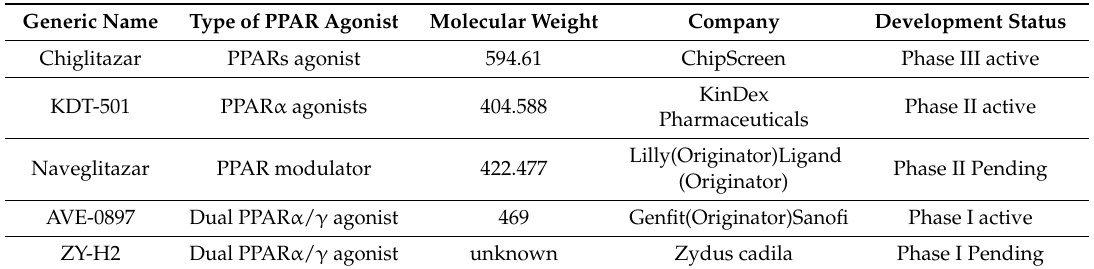
Table 3. Drugs of PPAR ligands for type 2 diabetes treatment in clinical